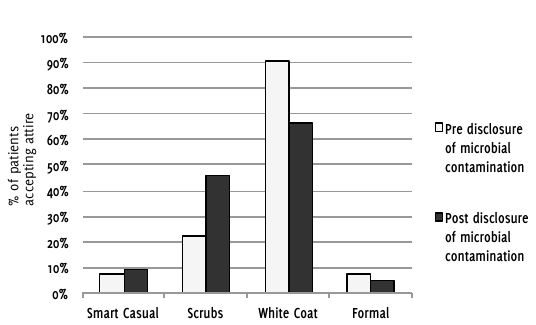
Note: Patients may choose to accept more than one attire. Percentages from total patient population, N=262.